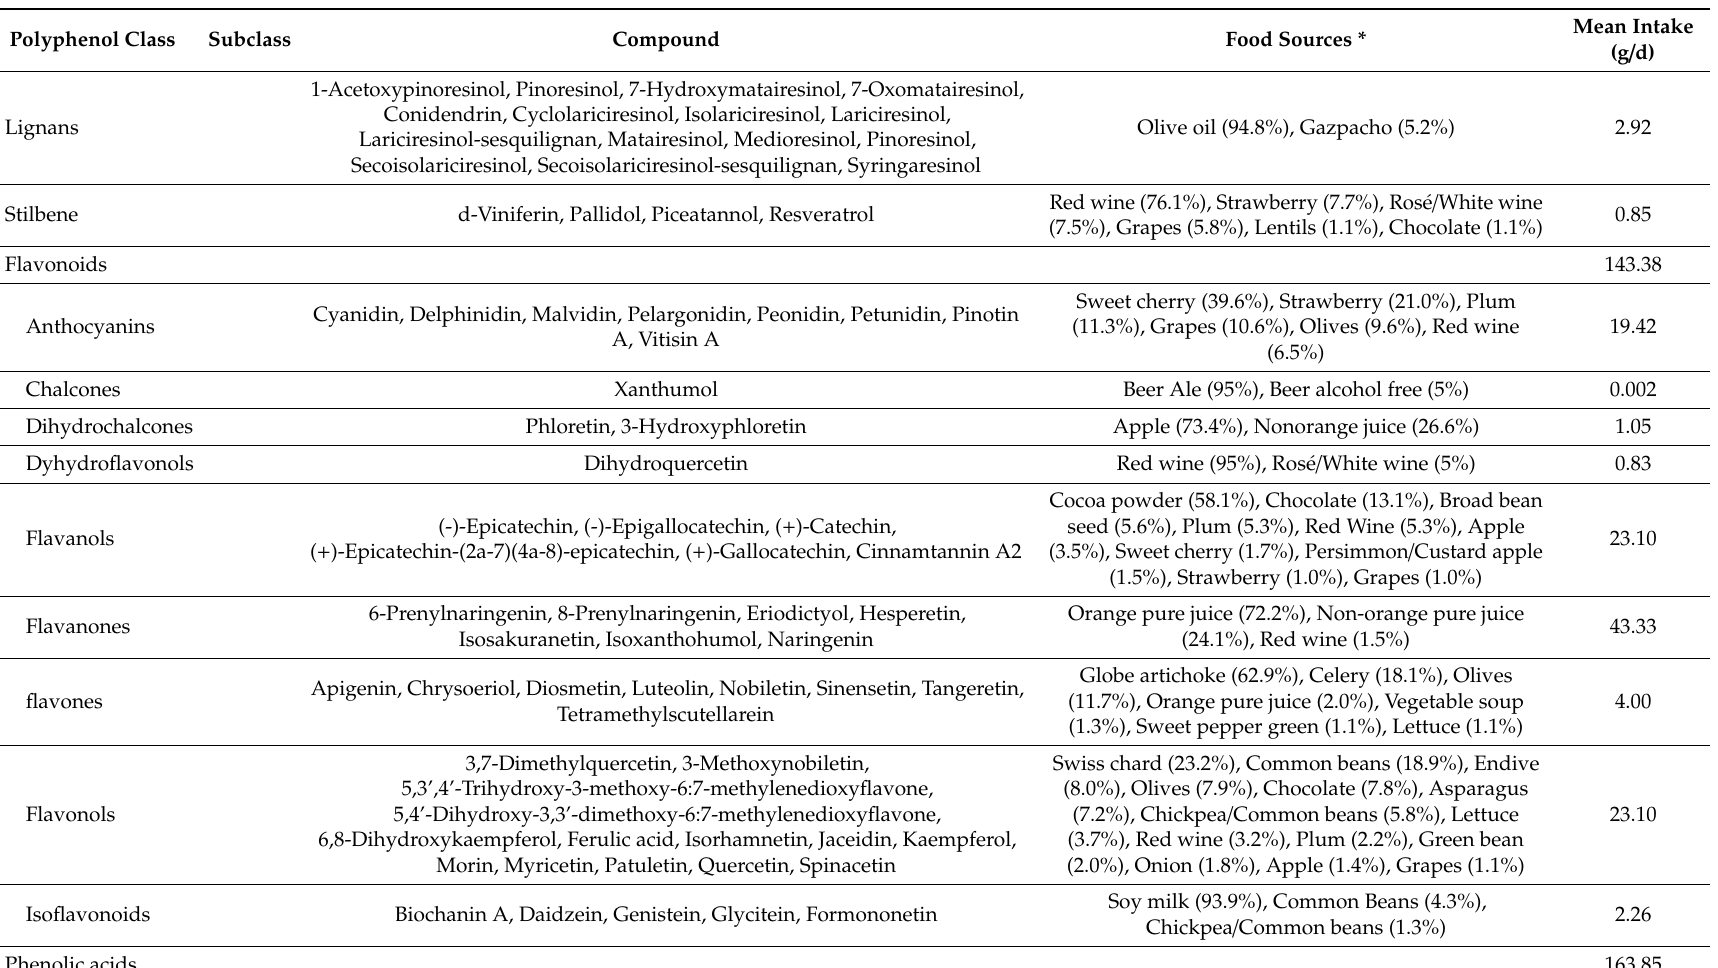
Table 2. Main foods that contribute more to each subclass of